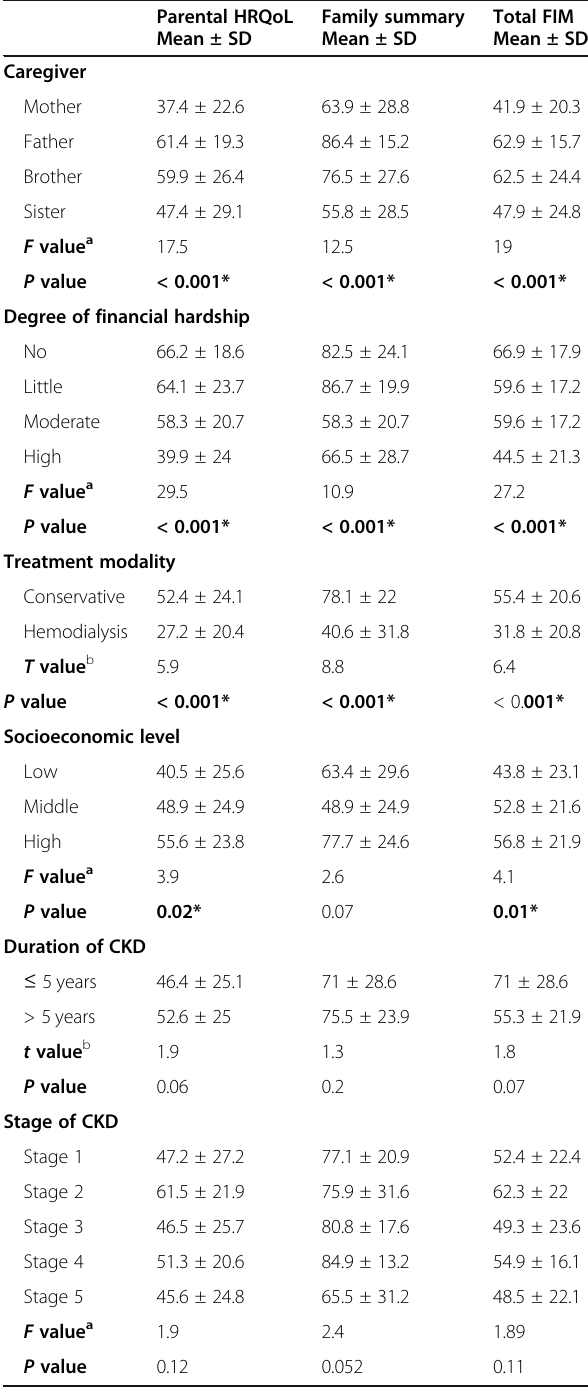
Table 4 Mean scores of PedsQL ™ Family Impact Module in caregivers of CKD children, Assiut, Upper Egypt, 2018